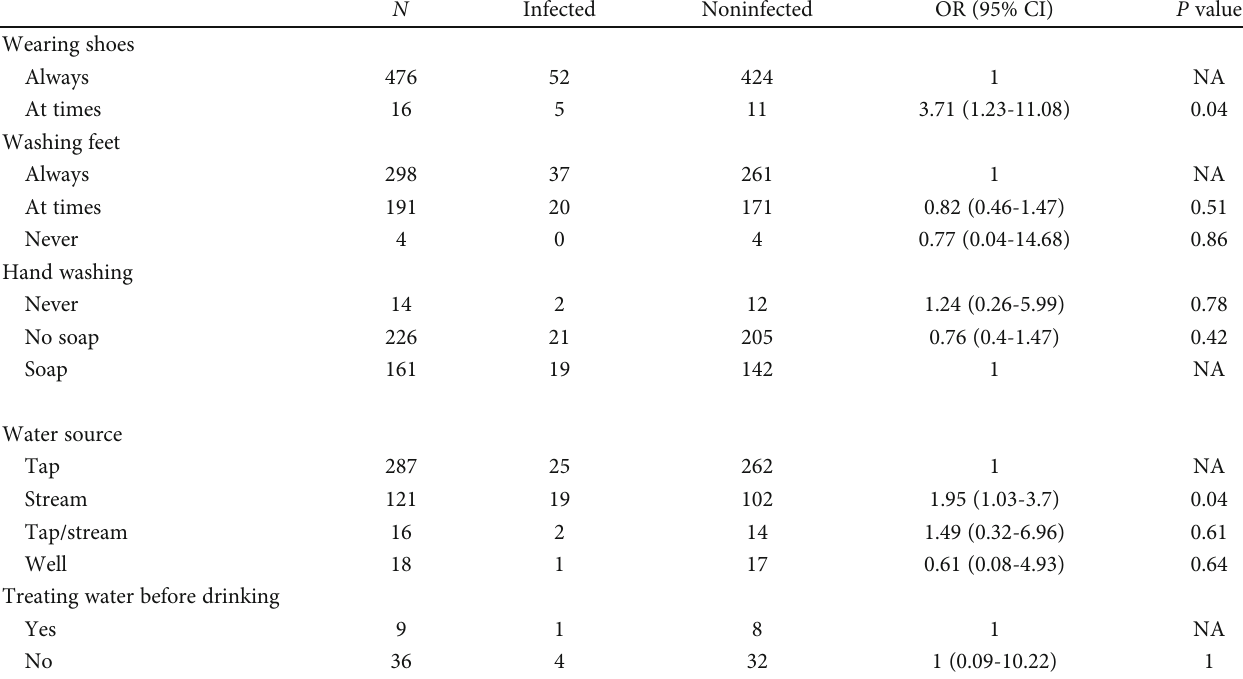
Table 9: Association between potential risk factors and helminth infection among school children in